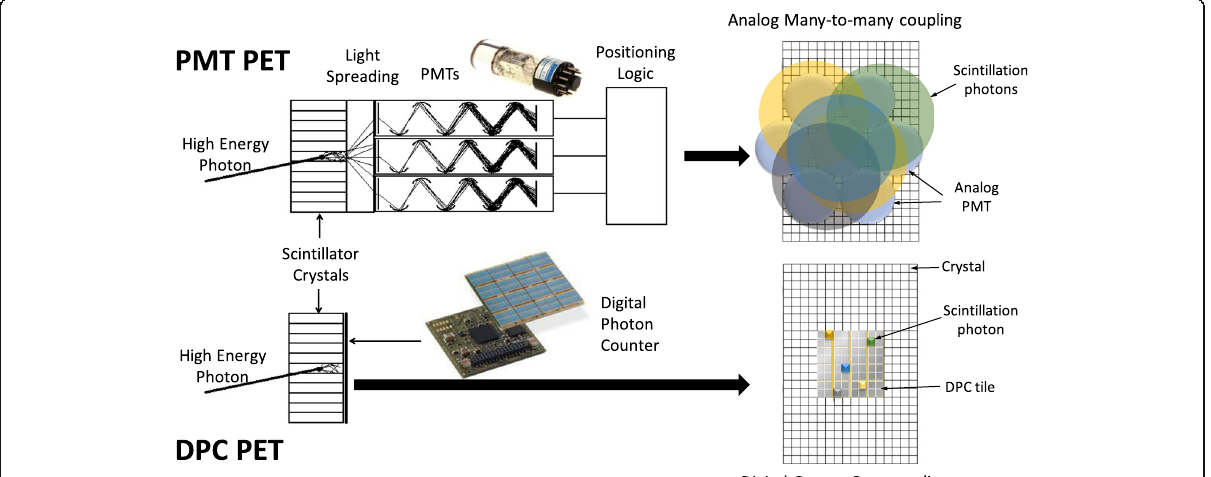
Fig. 3 Comparison of PMT PET detector and DPC PET detector approach. For PMT PET, incident photons are converted to visible light via interaction with scintillators coupled with multiple PMTs to generate and multiply electronic signals for further Anger-logic positioning decoding which exhibits significant dead time. For DPC PET, 1:1 coupling of scintillator and digital detector directly channels lights from a crystal to its ‘ own ’ detector with a digital signal output that is virtually dead time